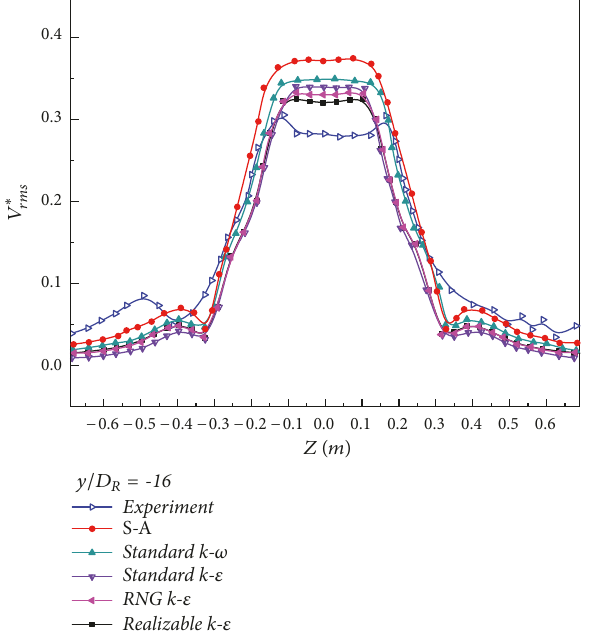
Figure 5: Comparison of dimensionless RMS velocity between numerical data and experimental data in different turbulence models.